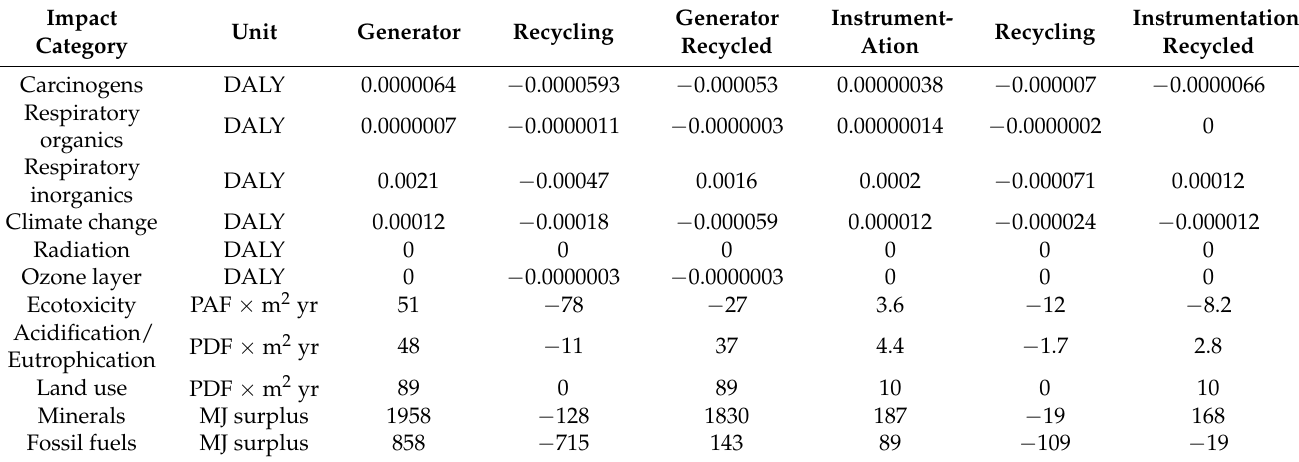
Table 6. Results of characterization of environmental consequences at the stage of manufacturing and recycling of instrumentation and generators of an innovative wind